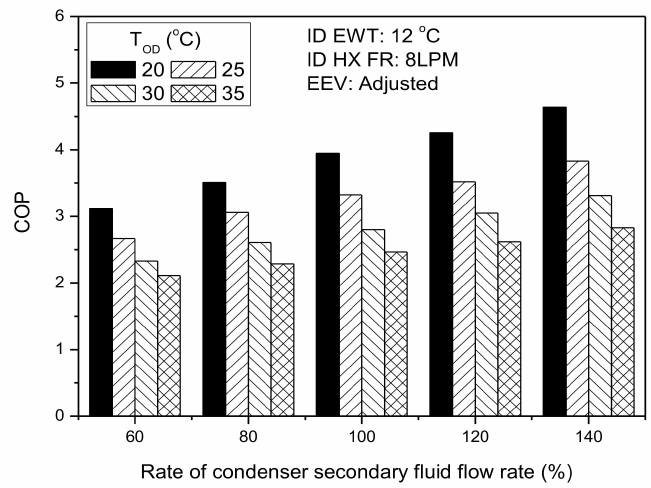
Figure 6. COP with the variation of condenser flow rate and T OD